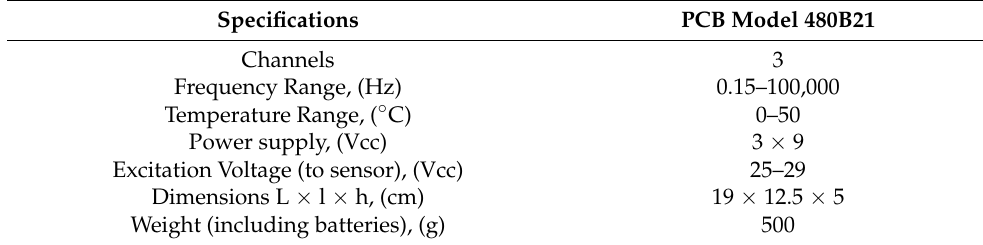
Table 2. Specifications of PCB signal conditioner model 480B21 [65].